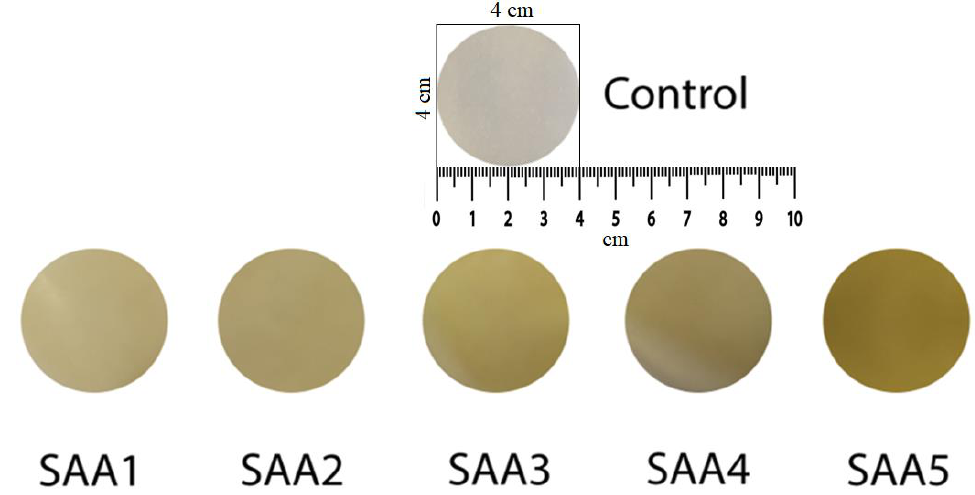
Figure 1. Color comparison between samples with ascorbic acid (SAA) addition and control sample. SAA1-5 concentration from 0.10 to 0.45 g.